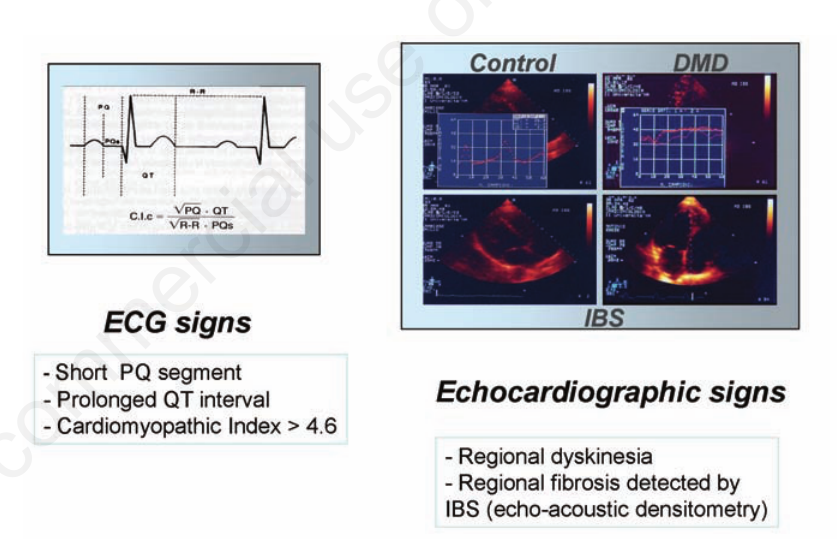
Figure 4. Preclinical stage of dystrophinopathic cardiomyopathy: elettrocardiographic and echocardiographic signs.